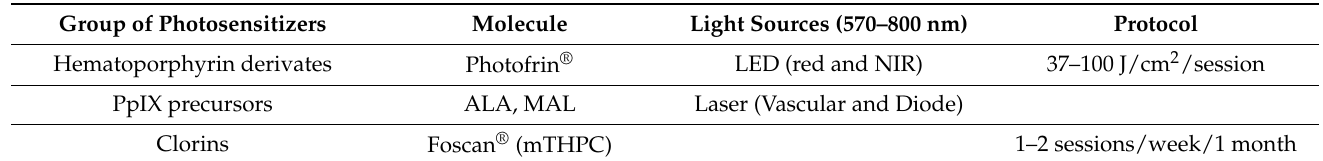
Table 6. Summary of some of the photosensitizers (PS) and light sources used in photodynamic therapy (PDT) in wound healing (WH).